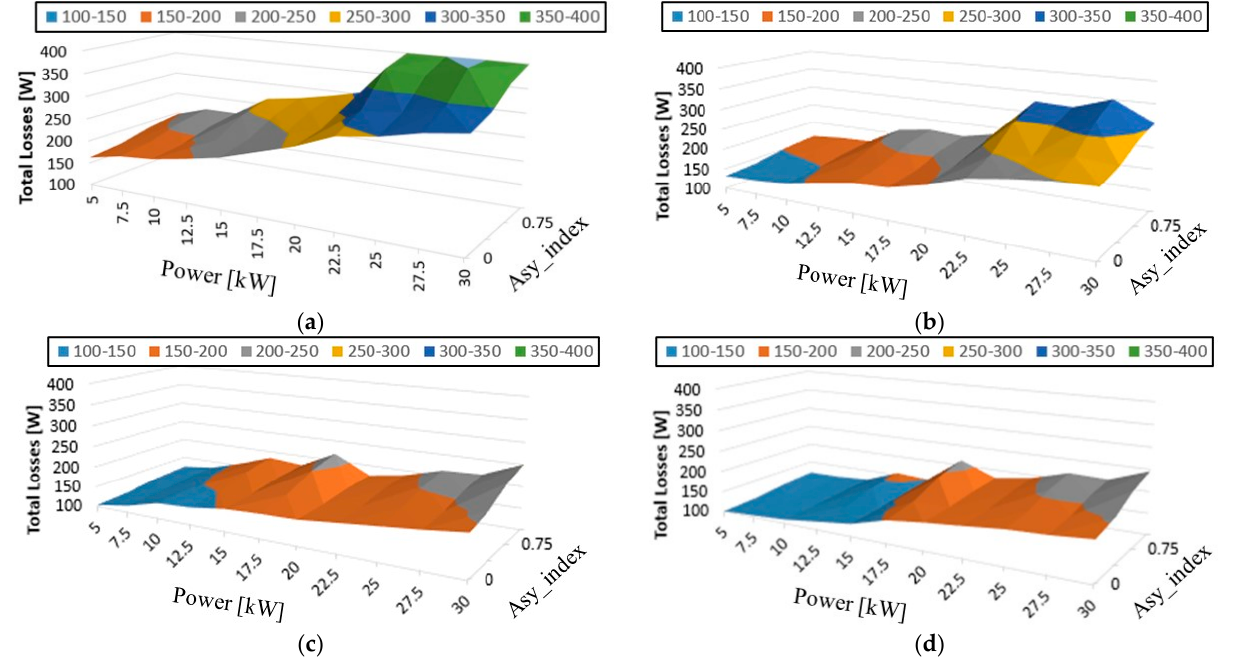
Figure 13. Comparison of total losses performance of a four-leg inverter under unbalanced load condition: ( a ) two-level three-leg four-wire type, ( b ) two-level four-leg type, ( c ) three-level three-leg four-wire type, and ( d ) three-level type four-leg inverter.